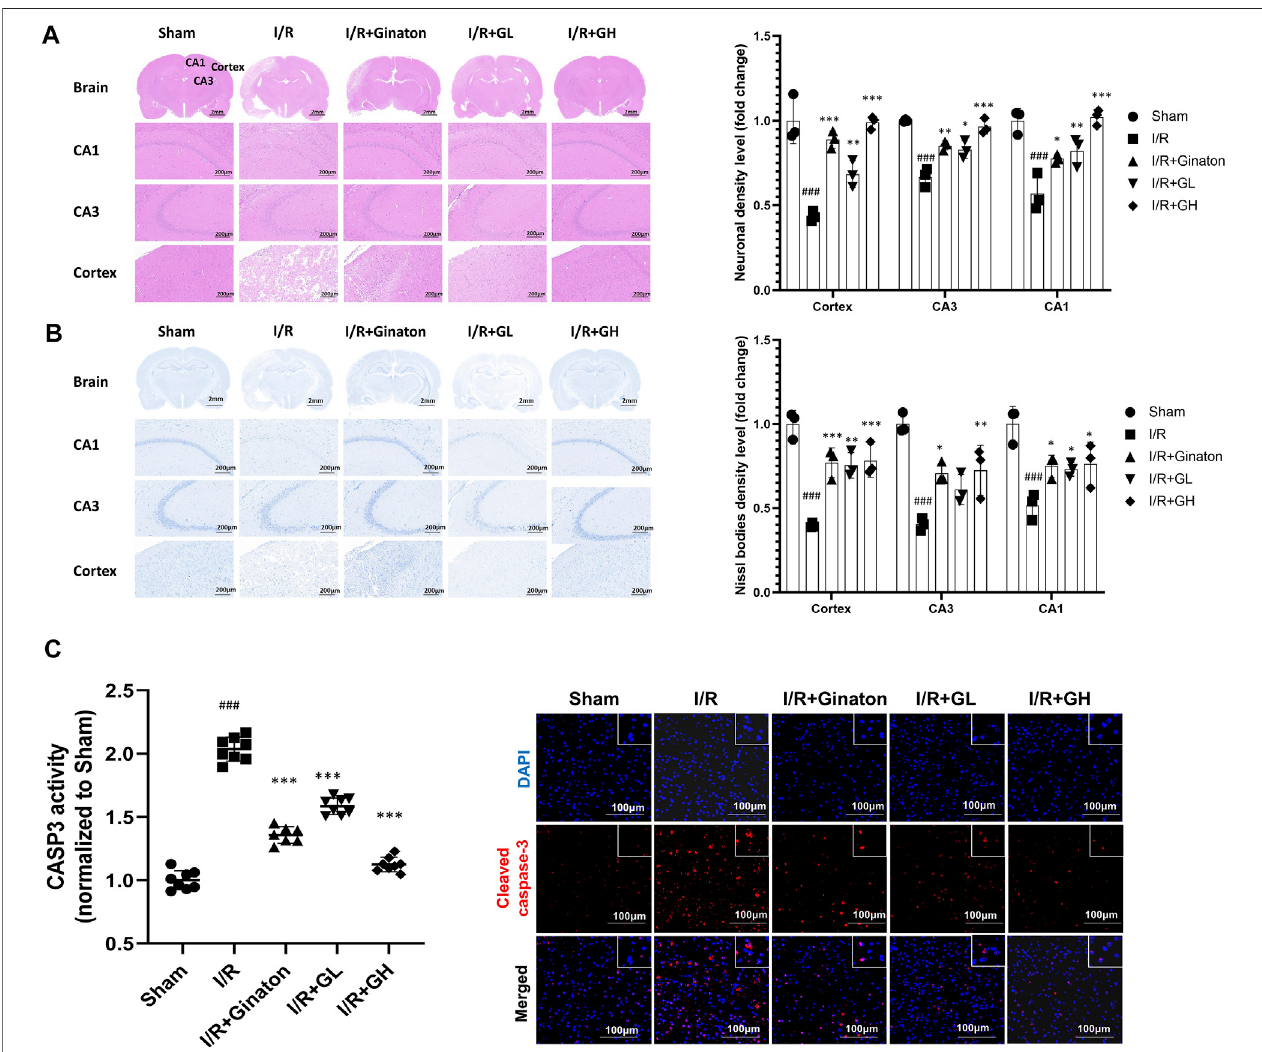
FIGURE 7 | Administration of GHI for 6 days reduced neuron loss after IRI; (A) H&E staining and the relative density (fold change of sham) in the cortex and hippocampal CA1 andCA3 regionsforeach group( n =3); (B) Nisslstainingand Nisslbodiesdensity level (foldchangeofsham) inthecortex andhippocampal CA1and CA3regionsforeachgroup( n =3); (C) CASP3activity( n =6 – 8)andIFforcleavedCASP3(red) ### p < 0.001comparedwithsham,* p < 0.05,*** p < 0.001comparedwith the I/R